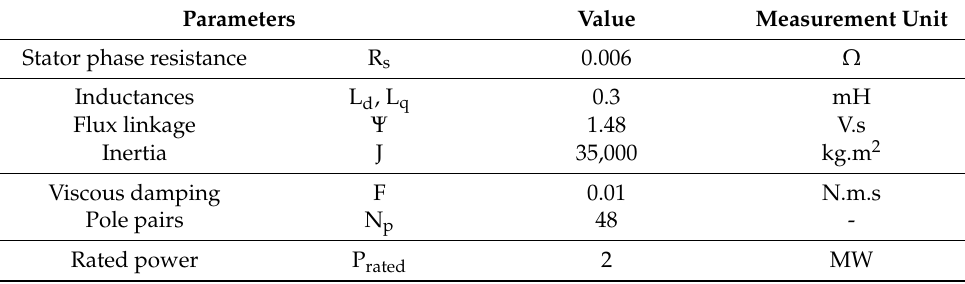
Table 1. PMSG parameters implemented for wind turbine modeling.